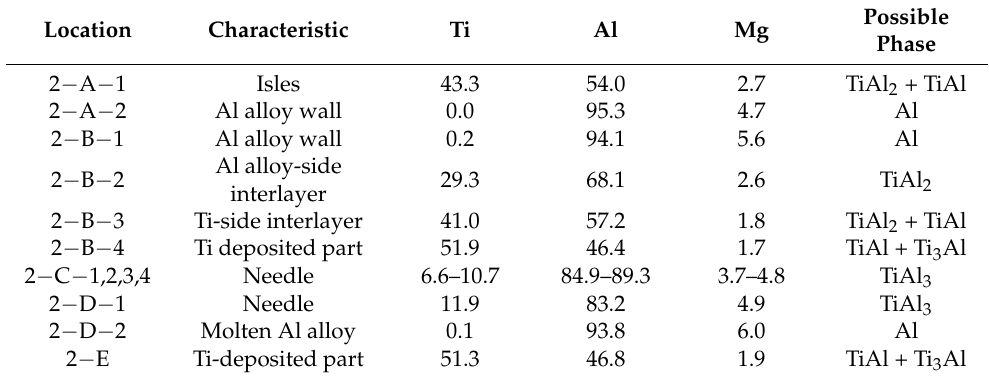
Table 4. EDS results of the selected areas